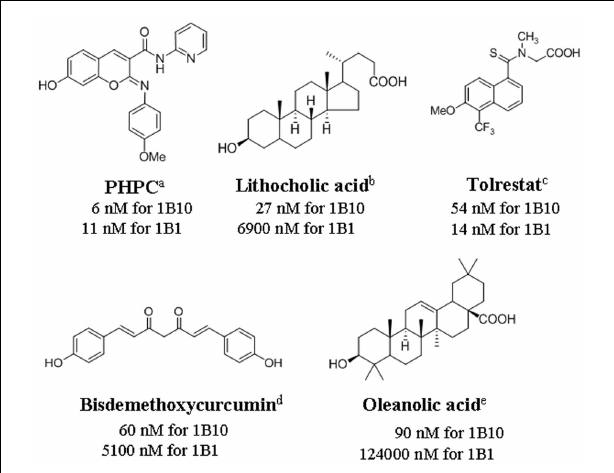
FIGURE 7 | Structures and IC 50 values of representativeAKR1B10 inhibitors. The IC 50 values for AKR1B10 (1B10) and AKR1B1 (1B1) are taken from a Endo et al. (2010a), b Endo et al. (2009), c Endo et al. (2010b), d Matsunaga et al. (2009), e Takemura et al. (2011).